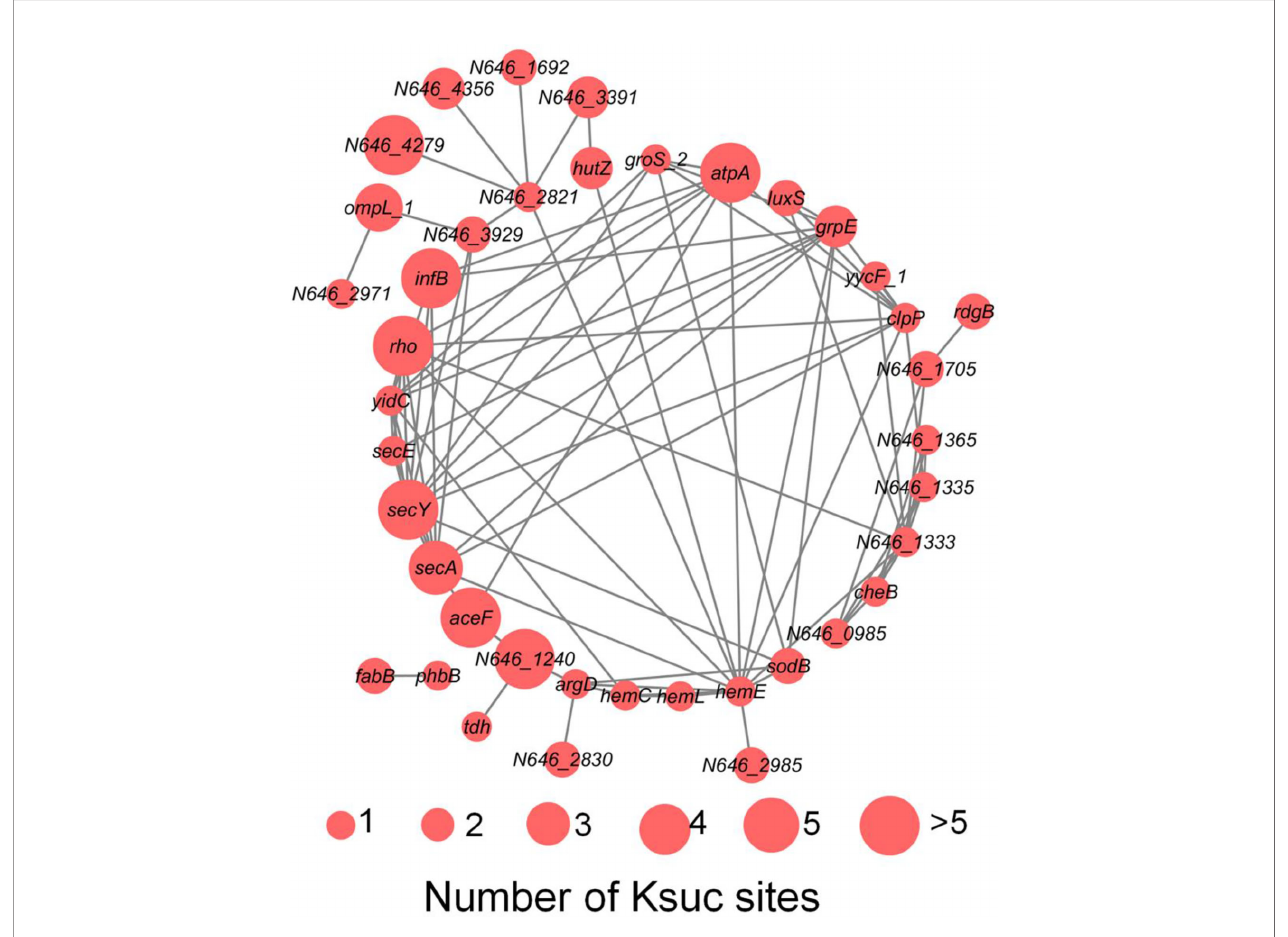
FIGURE 9 | The PPI network of succinylated virulence factors in V. alginolyticus . The size of the circle represents the number of Ksuc